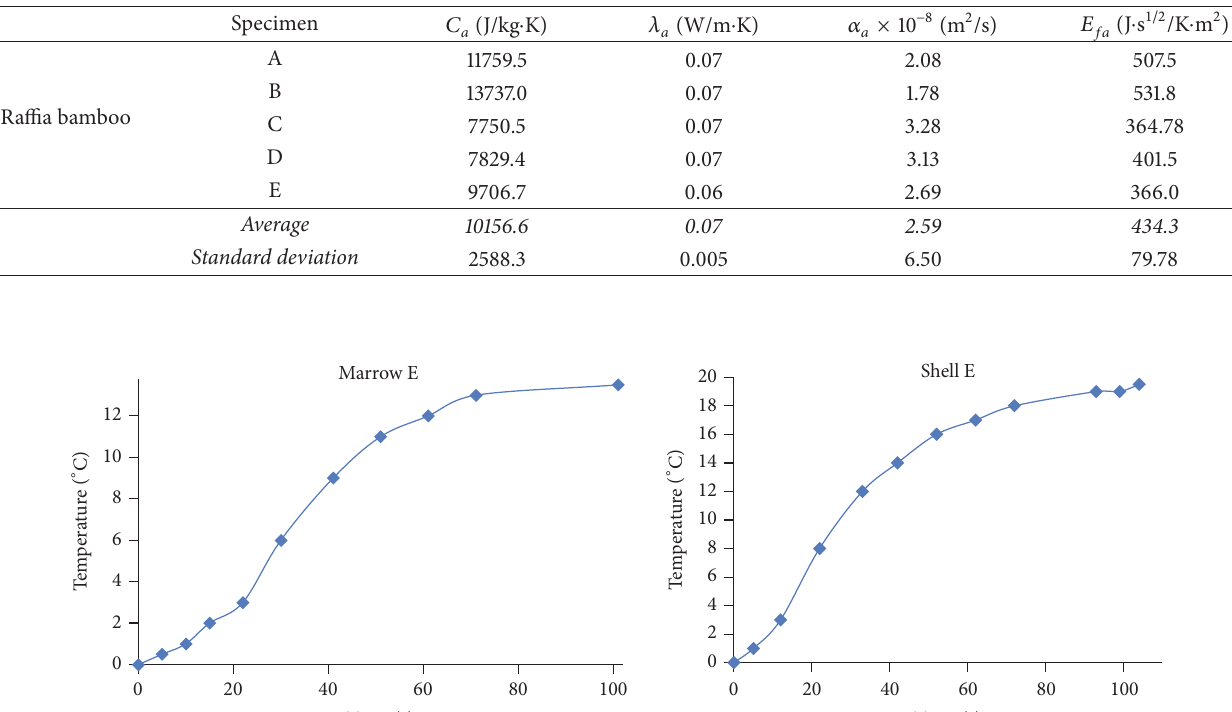
Table 6: Global thermal properties dry raffia bamboo.